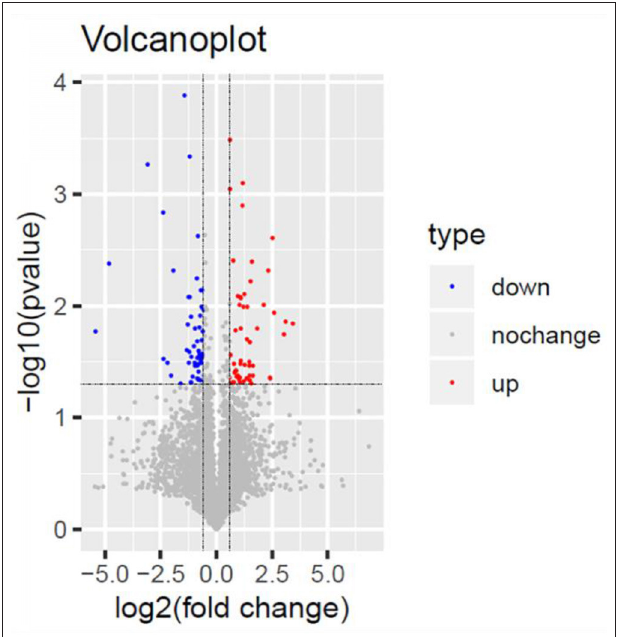
FIGURE 6 | Volcano Plot. Volcano Plot of the 110 significantly dysregulated proteins between the TSC1 truncating mutation group and the control group. Blue represents the downregulated protein expression and red indicates the upregulated protein.